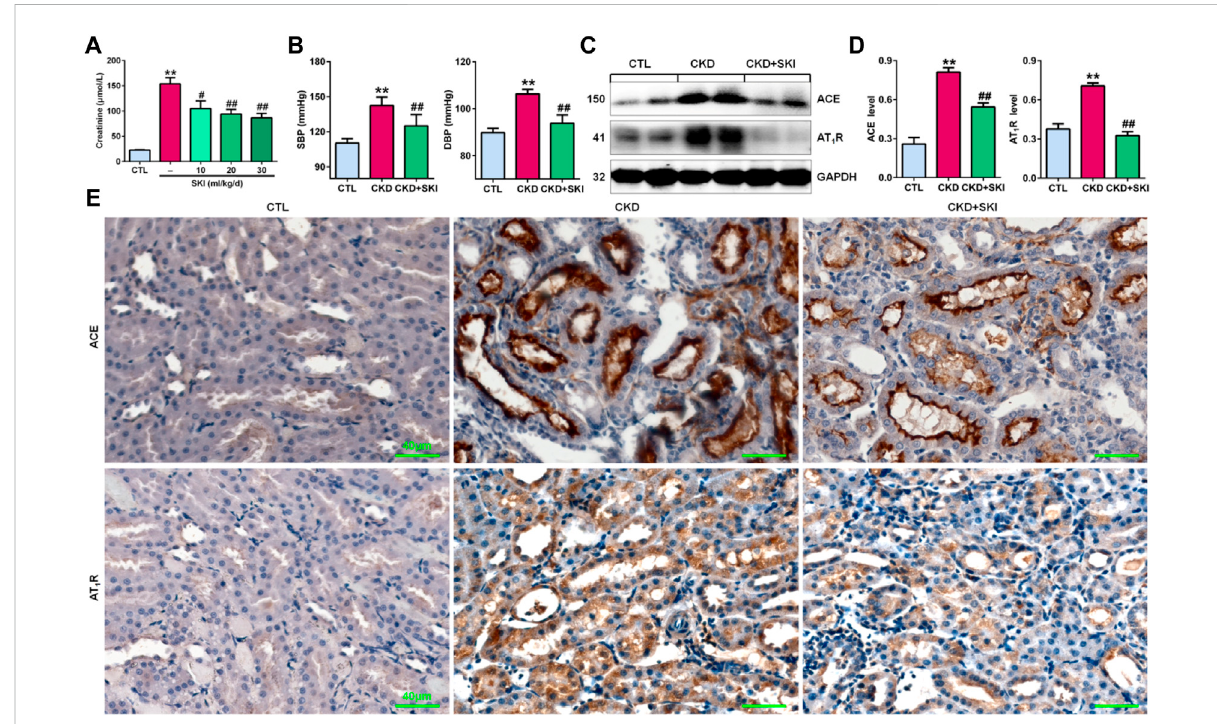
FIGURE 1 SKI controlled blood pressure and inhibited RAS activation in CKD rats. (A) Serum creatinine levels in adenine-induced rats treated with three doses of SKI (10, 20, 30 ml/kg/d). (B) SBP and DBP in adenine-induced rats treated with SKI. (C) Protein expression of intrarenal RAS components, including ACE and AT 1 R, in adenine-induced rats treated with SKI. (D) Quantitative analysis of the protein expression of intrarenal RAS components, including ACE and AT 1 R, in adenine-induced rats treated with SKI. (E) Immunohistochemical analysis of intrarenal ACE and AT 1 R in adenine- inducedratstreatedwithSKI.Scalebar,40 μ m** p < 0.01comparedwithCTLrats; # p < 0.05, ## p < 0.01comparedwithCKDrats.Abbreviations:DBP, diastolic blood pressure; SBP, systolic blood pressure; SKI, shenkang